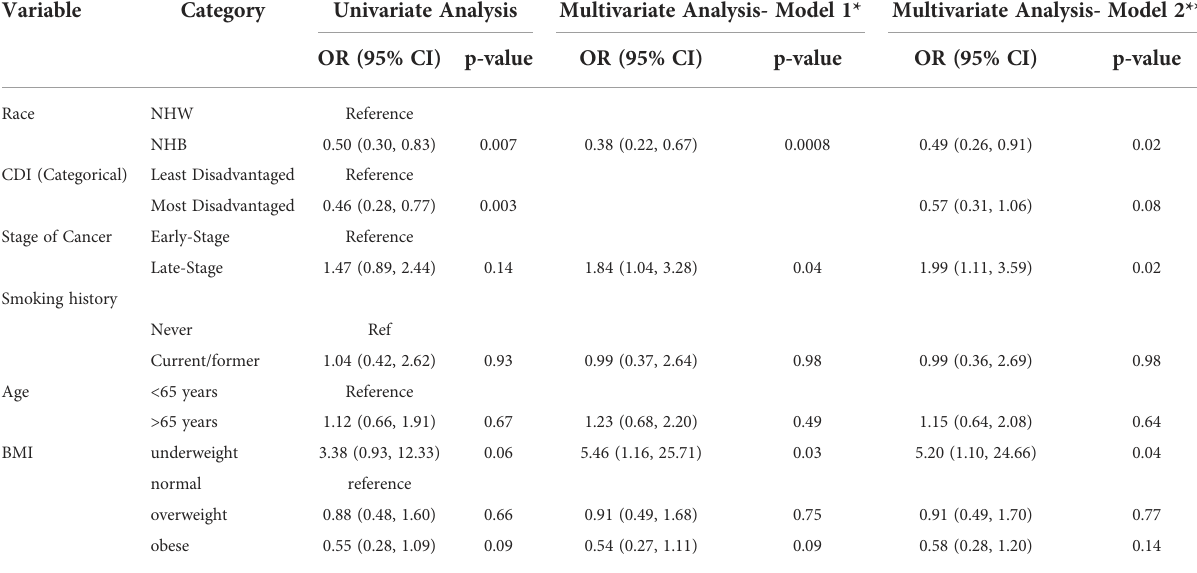
TABLE 3 Univariate and adjusted logistic regression estimates of the association between demographic and clinical characteristics and in fl ammation prevalence (NLR ≥ 3).